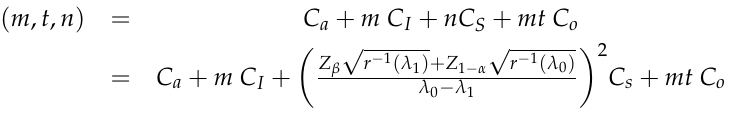
for c 1 = 0.825, 0.85 L